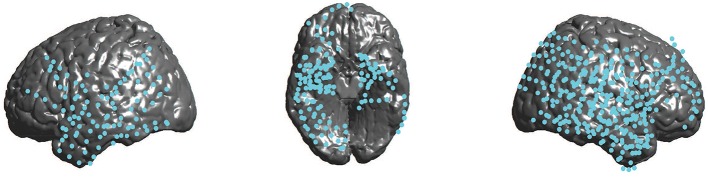
Locations of all cortical electrodes in our dataset.